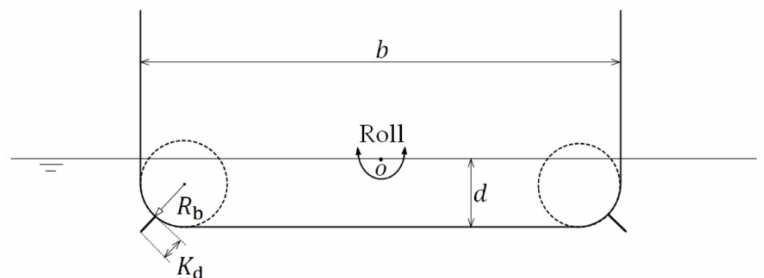
Figure 5. A semi-submerged S60 midship section with bilge keels harmonically rolls in the presence of a free surface; beam b = 0.237 m, mean draught d = 0.057 m, bilge radius R b = 0.035 m, bilge keel depth K d = 0.01 m, roll amplitudes θ = 0.15, 0.20, 0.25 ( rad ) . The rotation axis is located at the center of the